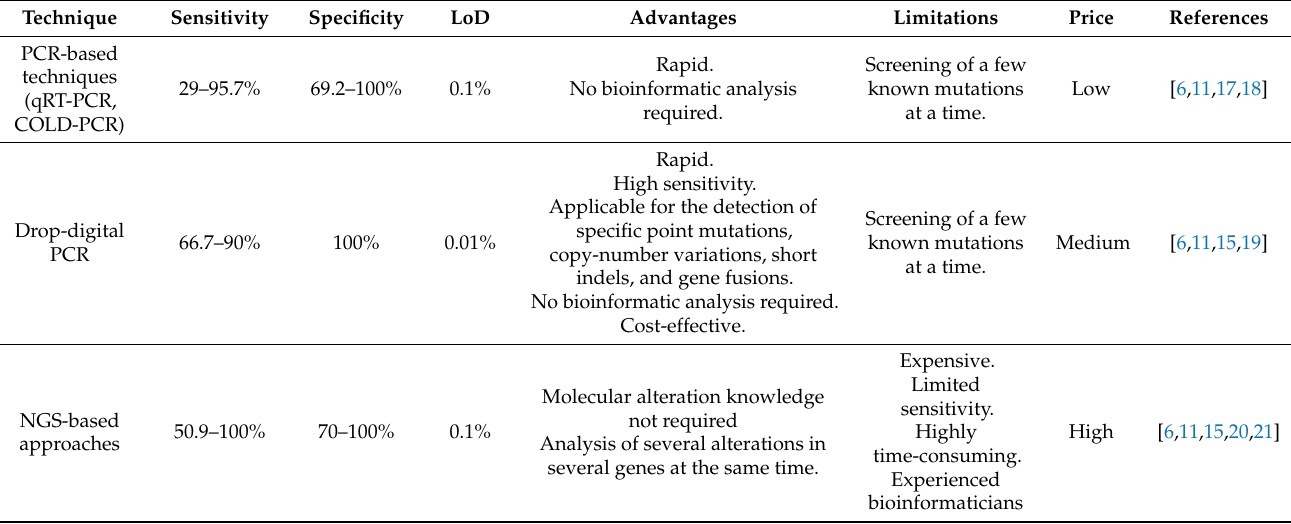
Table 1. Comprehensive comparison of liquid biopsy analysis